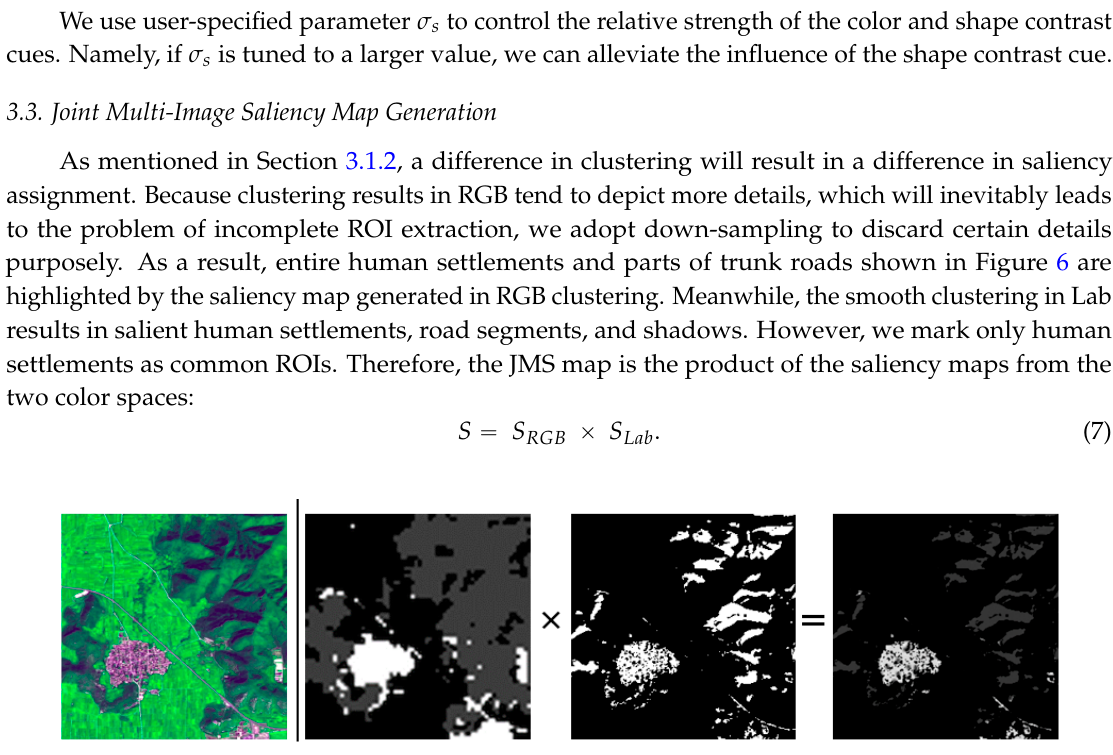
( d ) Figure 7. The generation and simple hole-filling of an ROI mask. ( a ) Original image; ( b ) Joint multi- image saliency map; ( c ) ROI mask; ( d ) filled ROI mask.